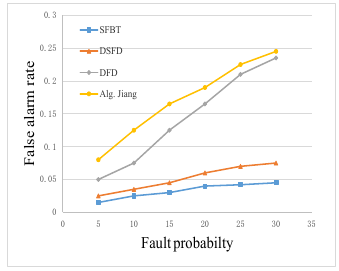
Figure 6. False alarm rate